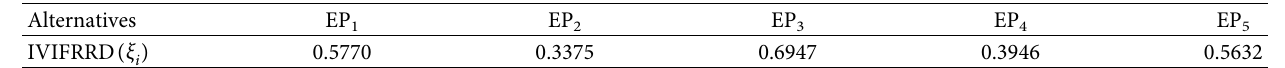
Table 12: IVIFRRD of each alternative from IFPIS.